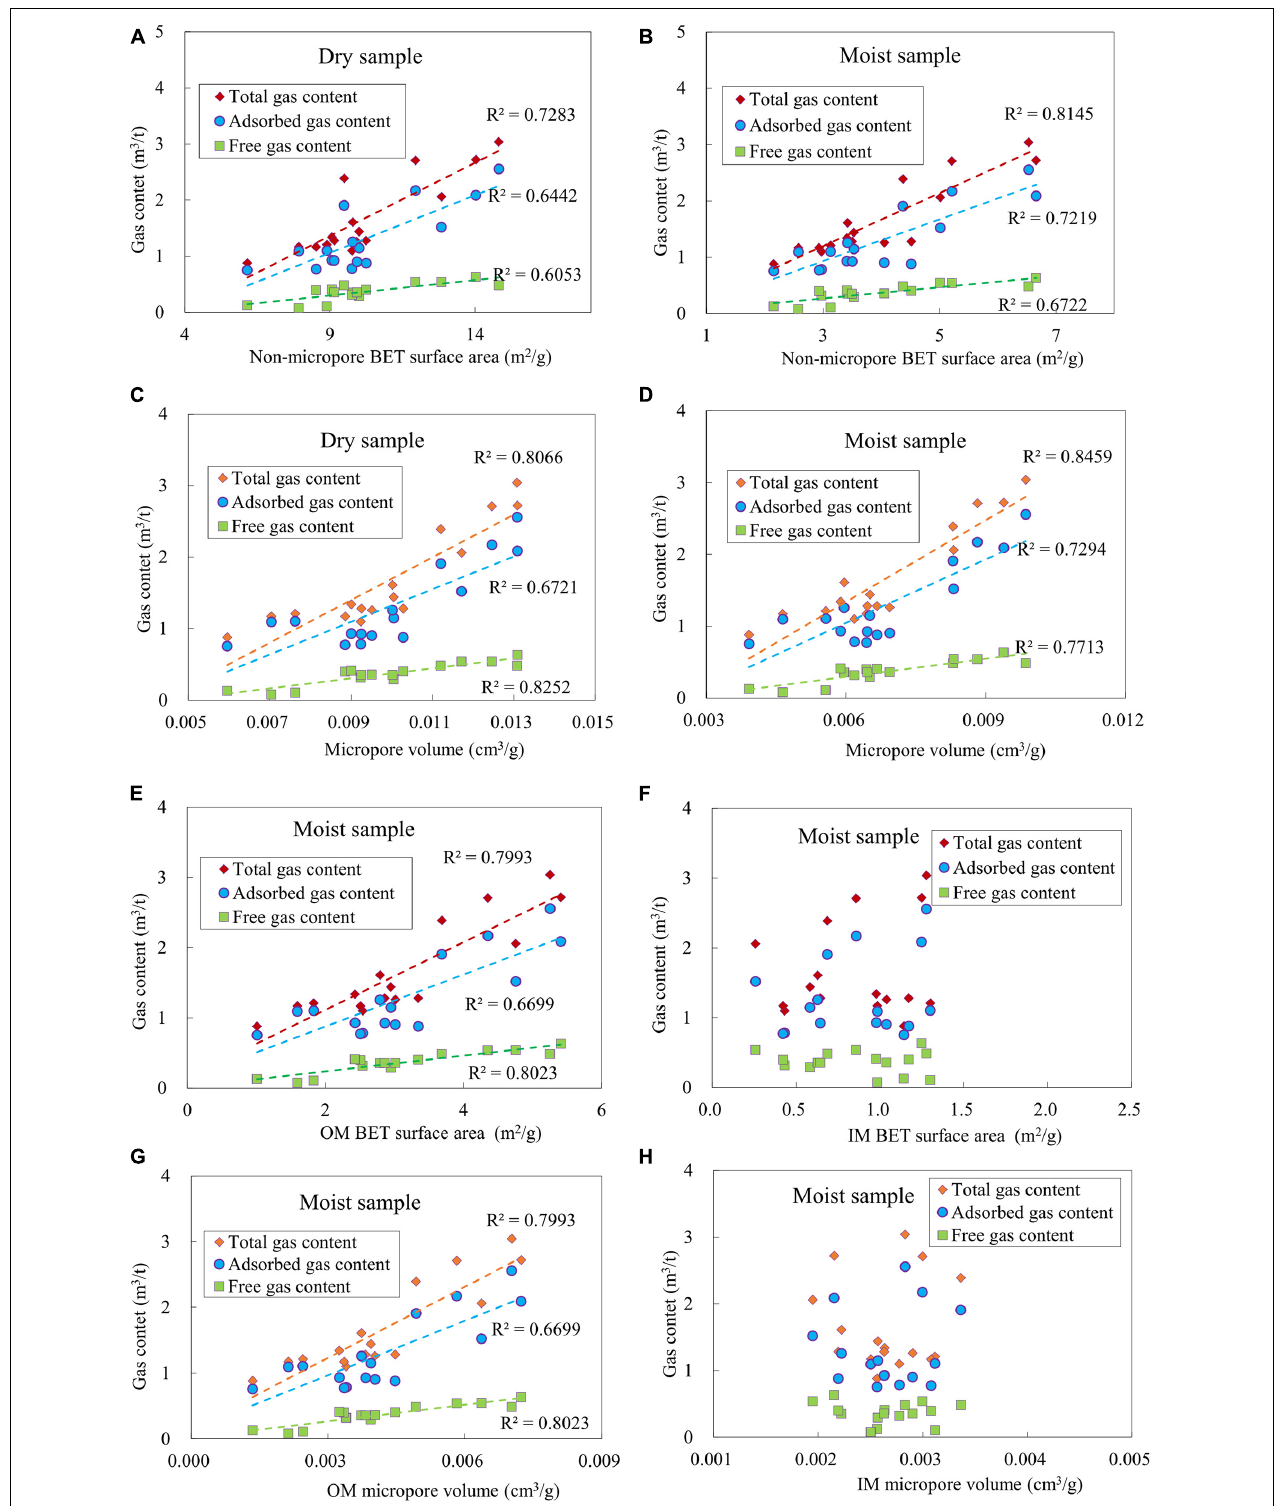
FIGURE 12 | Plots showing the correlations of the contents of absorbed, free and total gasses with the BET surface areas (A,B) and micropore volumes (C,D) for the studied shale samples, and the relationships of the contents of absorbed, free and total gasses with the OM, IM BET surface areas (E,F) and OM, IM micropore volumes (G,H) for the moist shale samples. (A–D) their correlations of the moist sample are obviously better than those of the dry sample; (E–H) the gas-bearing property shows positively relationships with the OM pore structure parameters, while displays no correlations with the IM pore structure parameters.